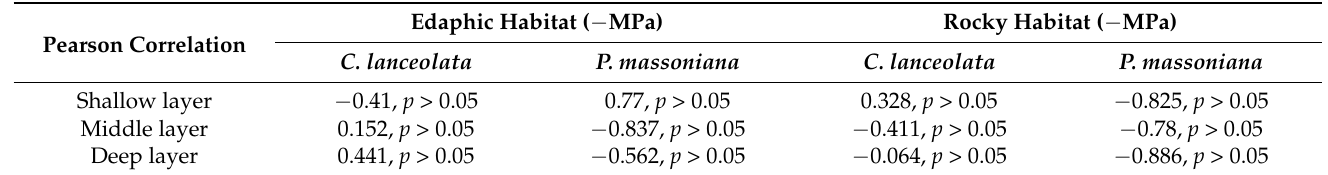
Table 4. Comparisons of δ 13 C values of C. lanceolata and P. massoniana in edaphic and rocky habitats.